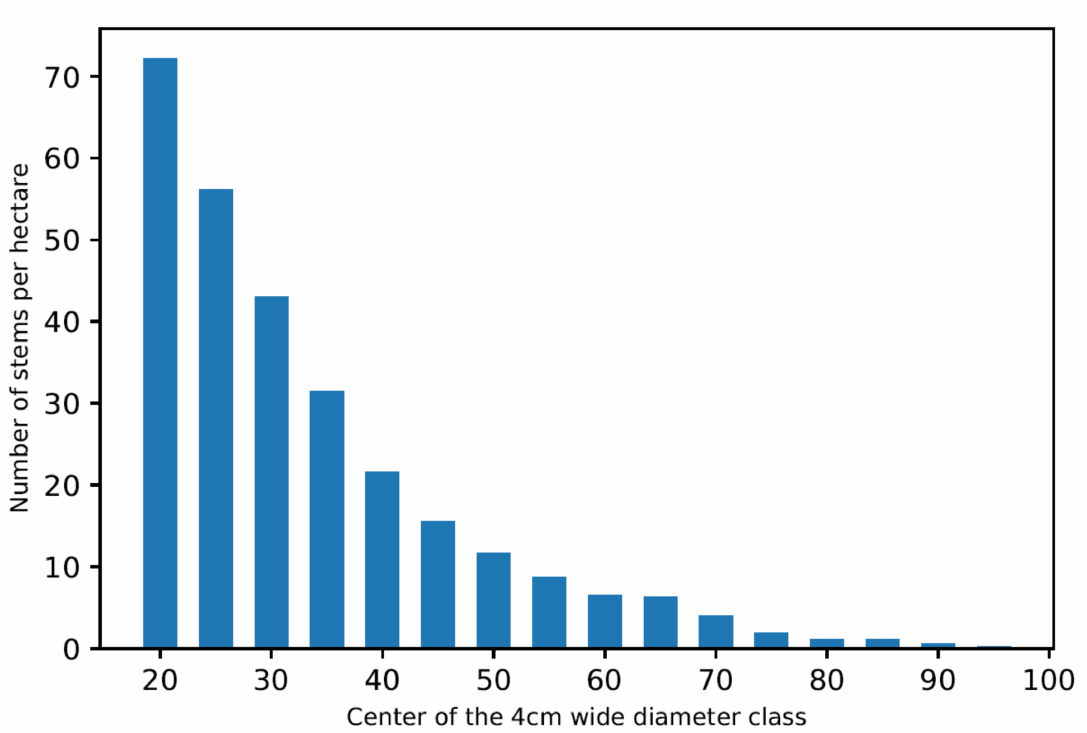
Figure 1. Example of a distribution of diameters in a forest division under selective felling manage- ment (division number 2202, inventory of